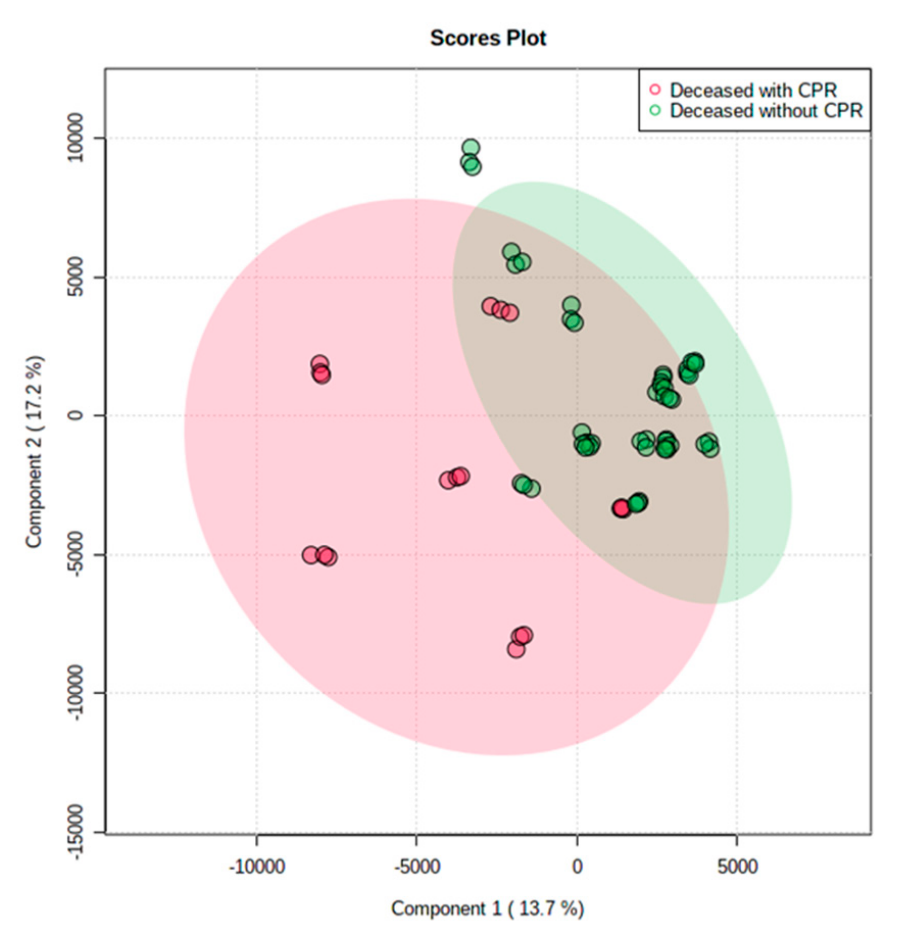
Figure 3. The principal component analysis score plots of deceased liver grafts with or without CPR. The plot showed that lipid metabolites were more various in deceased liver grafts with a history of CPR than without a history of CPR. Table 4. The difference of lipidomics in MS-electrospray positive ion mode between deceased donors with or without CPR.